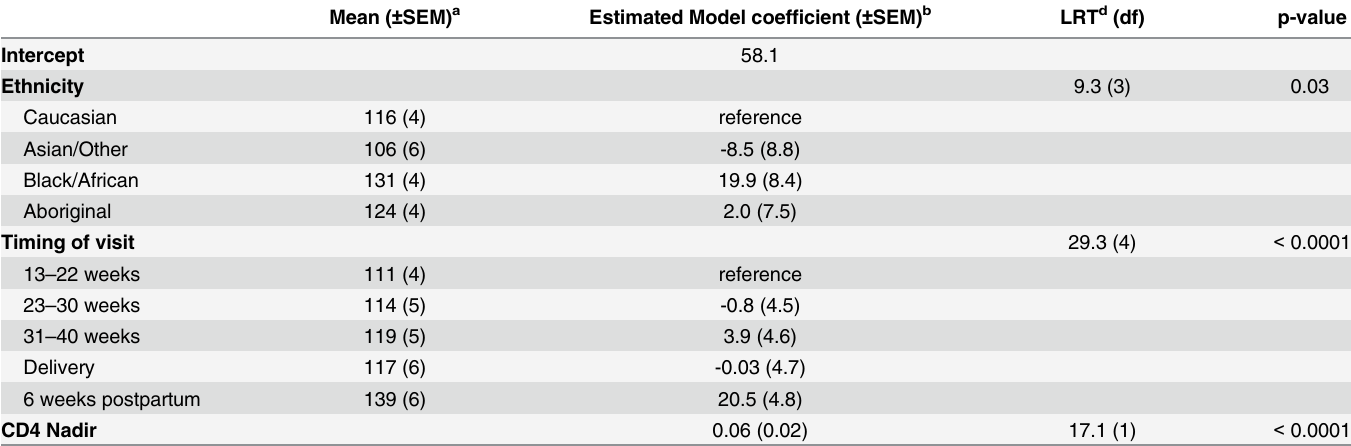
Table 6. Means, model estimates, and Chi-squared results for the mixed-effects modelling of mtDNA levels within the 63 HIV+ pregnant